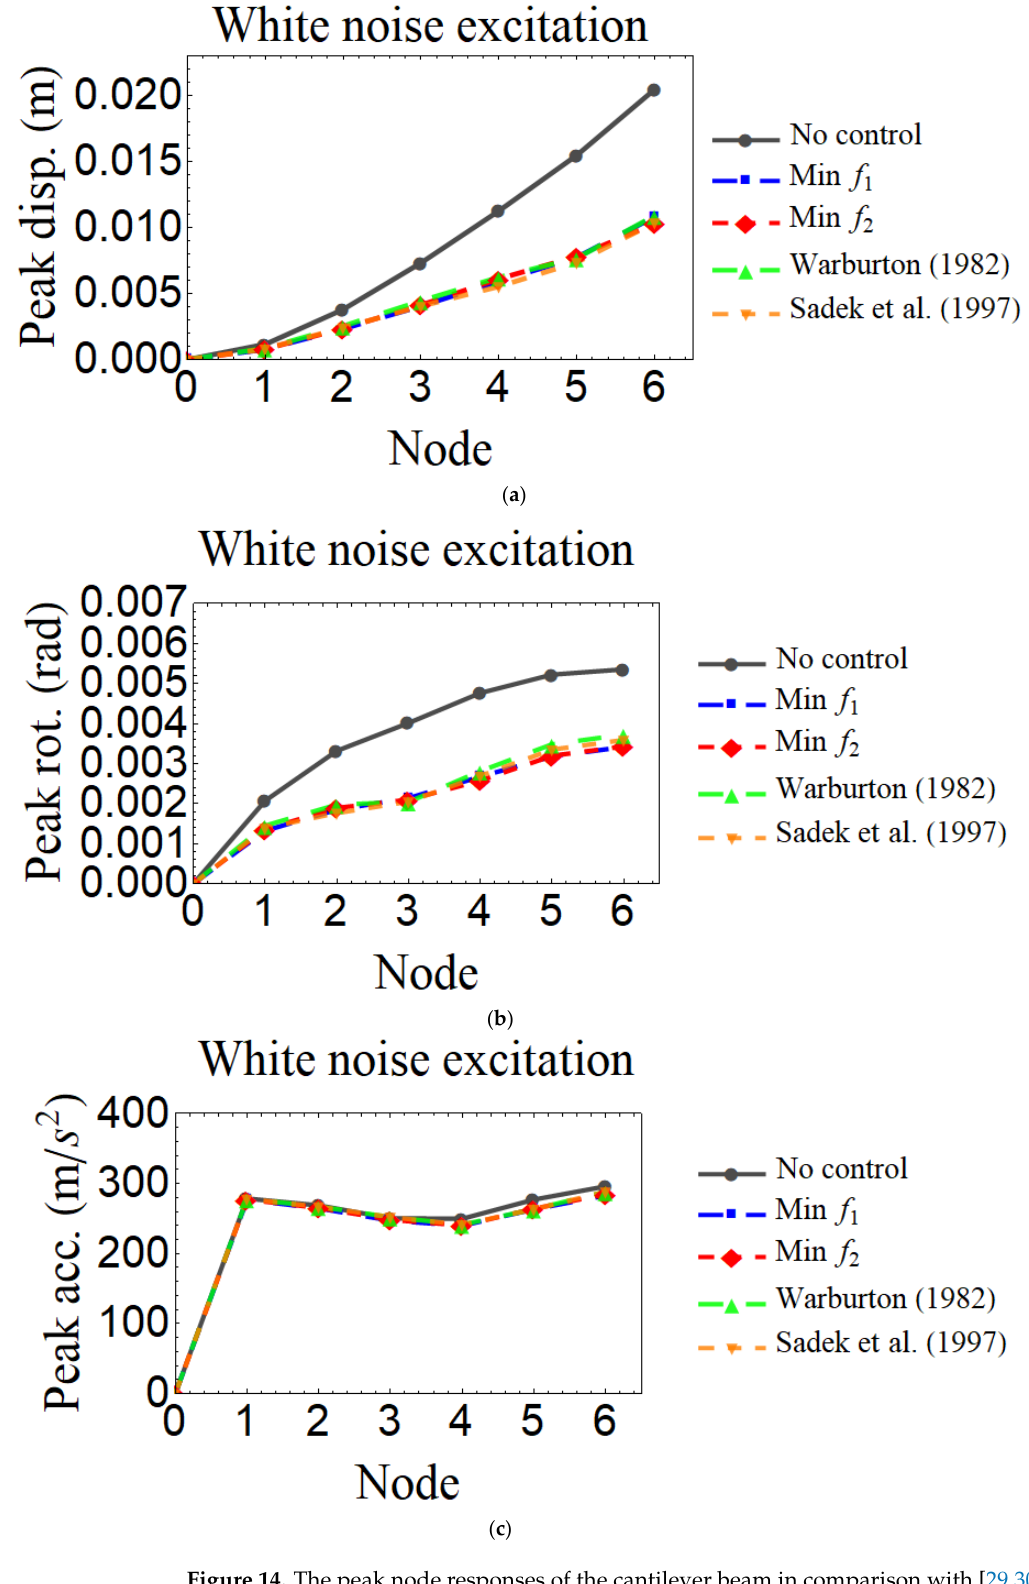
Figure 14. The peak node responses of the cantilever beam in comparison with [29], [30] to the white noise excitation considering f 1 and f 2 objective functions: ( a ) peak displacements, ( b ) peak rotations, and ( c ) peak accelerations.